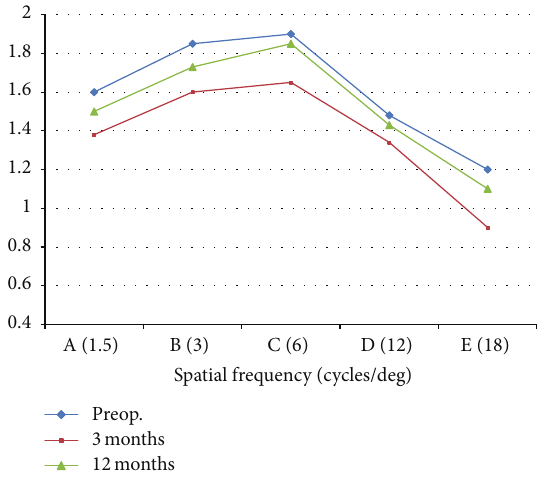
Figure 5: Anterior Segment Optical Coherence Tomography (AS- OCT) (Optovue, Fremont, CA) at 3 months and 12 months postop- erative.